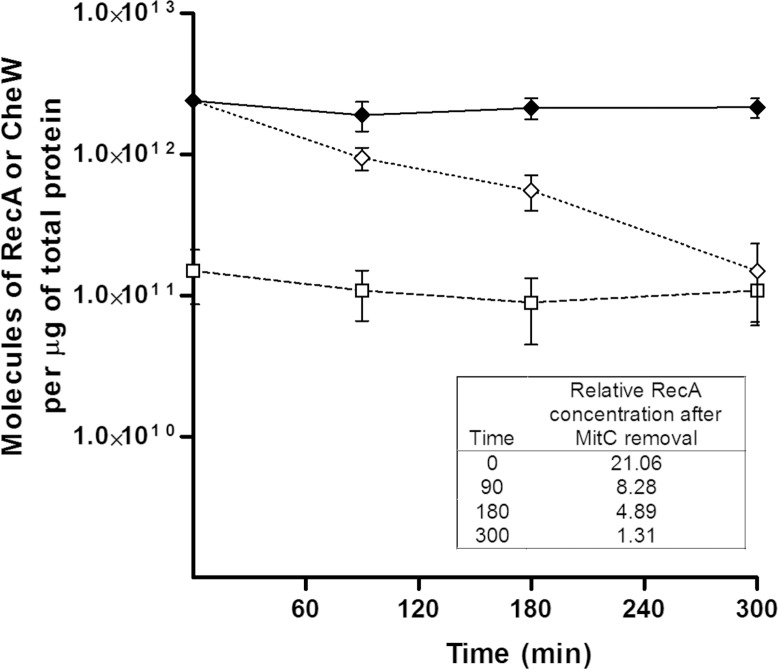
Concentration of RecA protein, as measured by ELISA, in S. enterica ΔcheR cells harboring plasmid pUA1127 (eYFP::cheR) and growing in liquid medium.Samples were taken periodically after the removal of mitomycin C from cultures pre-treated with 0.08 μg mitomycin C/mL for 300 min (◇, discontinuous dotted line). The amount of RecA of a non-treated culture (□, discontinuous line) and a continuously treated culture (◆, continuous line) served as controls. The RecA concentration is expressed as the number of RecA molecules per μg of total protein. The results are the mean of three independent experiments. Error bars represent the standard deviation. The relative RecA concentration after mitomycin C removal (boxed) was calculated as the mean RecA concentration at each time point with respect to the mean RecA concentration of the non-treated culture [1.13 (±0.25) x 1011 molecules per μg of total protein].